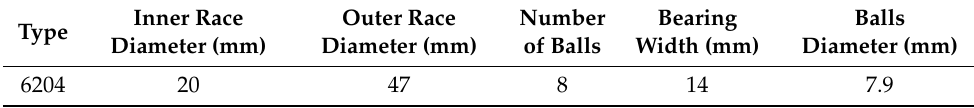
Table 1. Main parameters of the 6204 ball